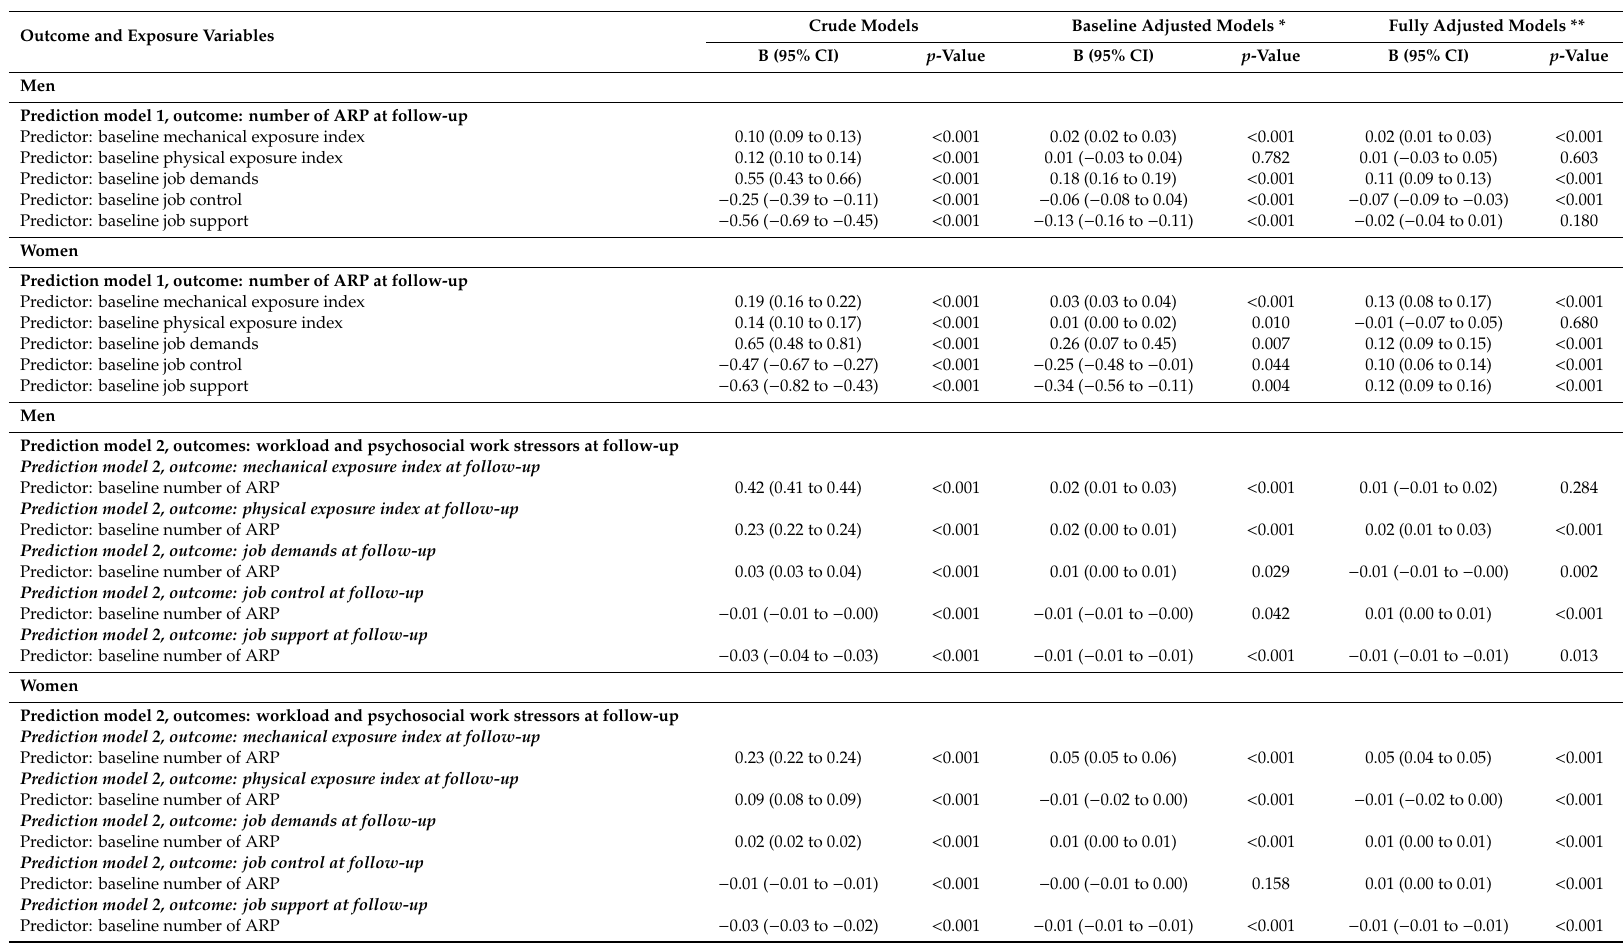
Table 5. Prediction models between workload, psychosocial work stressors, and the number of anatomical pain regions stratified by baseline gender. Outcome and Exposure